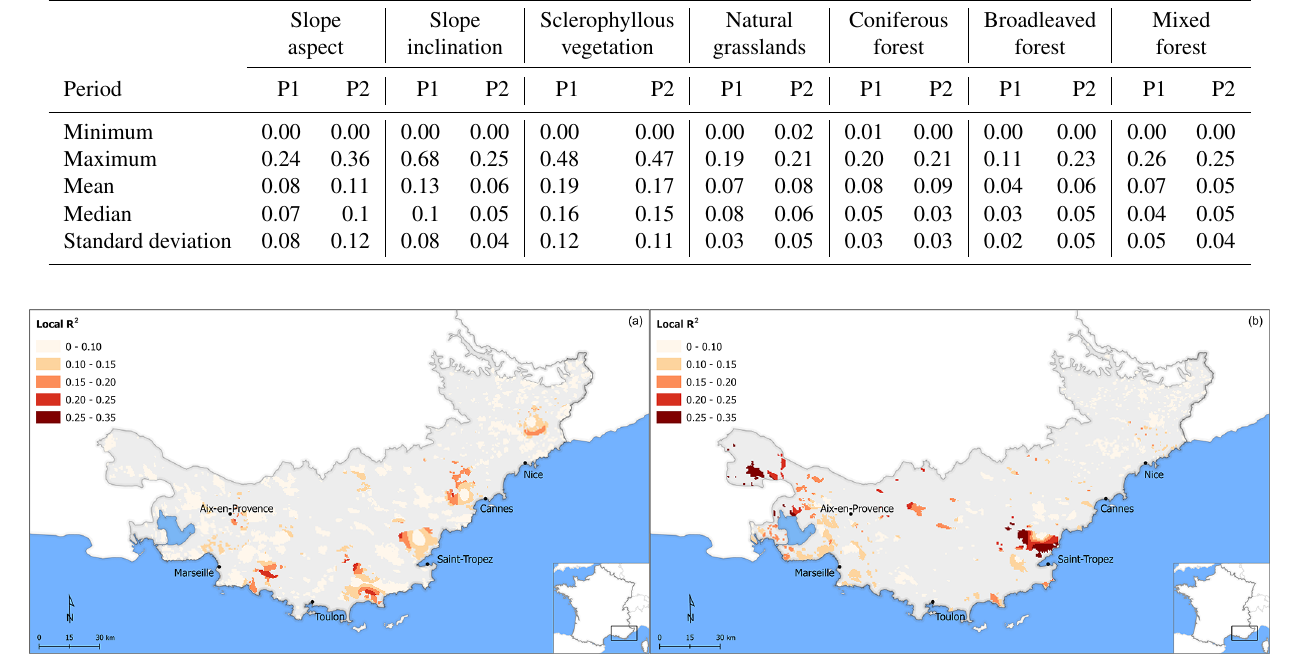
Figure 14. Spatial distribution of local R 2 between the burned area and slope aspect for 1970–1994 (a) and 1995–2019 (b)